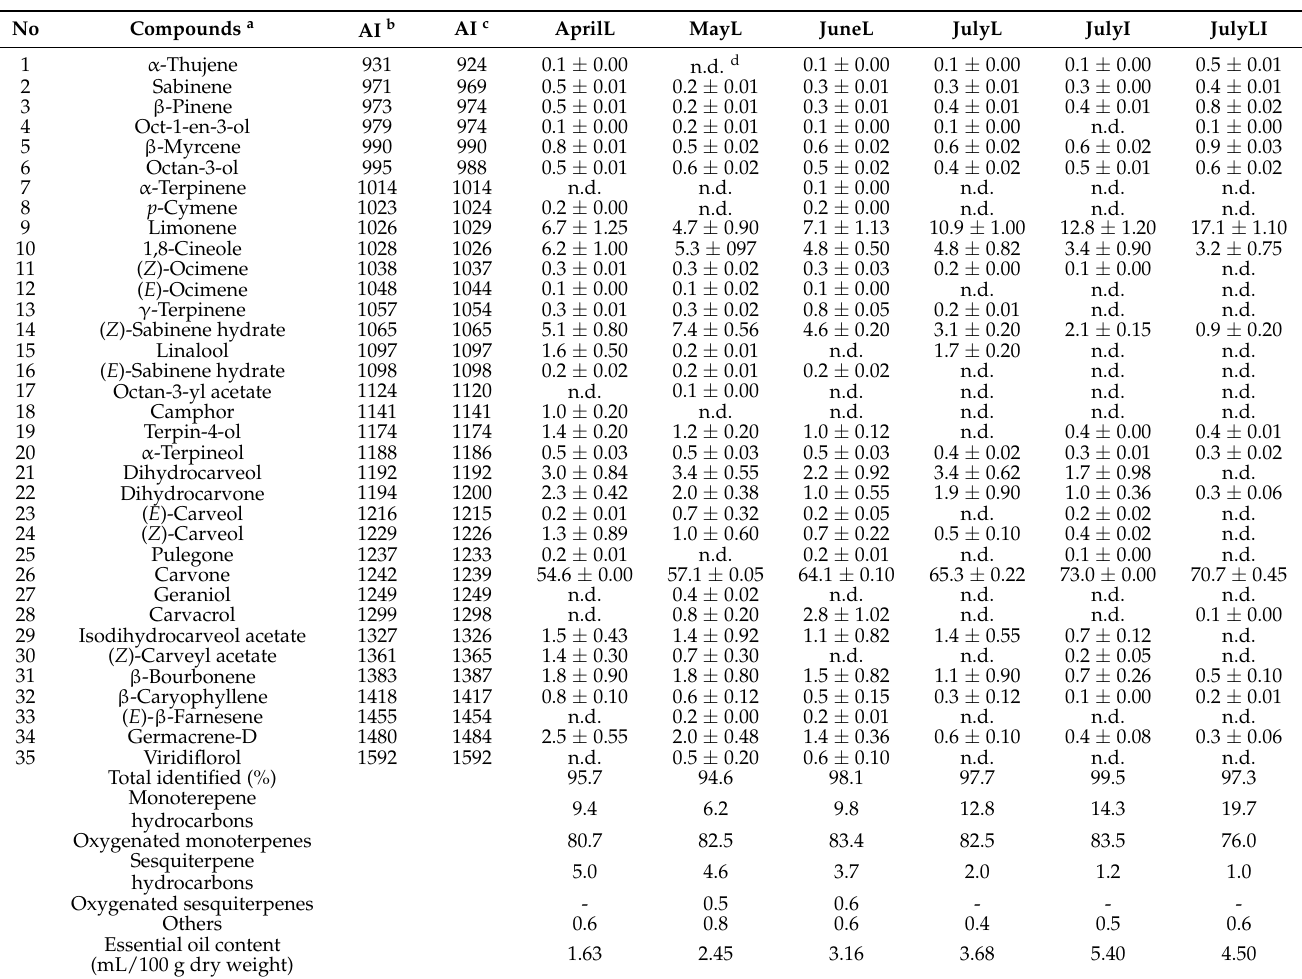
CATPCA analysis (Figure 3), constructed using axes 1 and 2, accounted for 83.40% of the total variability and the total value of Cronbach’s alpha (alpha = 0.994) based on the total eigenvalue indicated a high level of internal consistency. Table 2. Qualitative and quantitative composition of the Essential oils from M. spicata